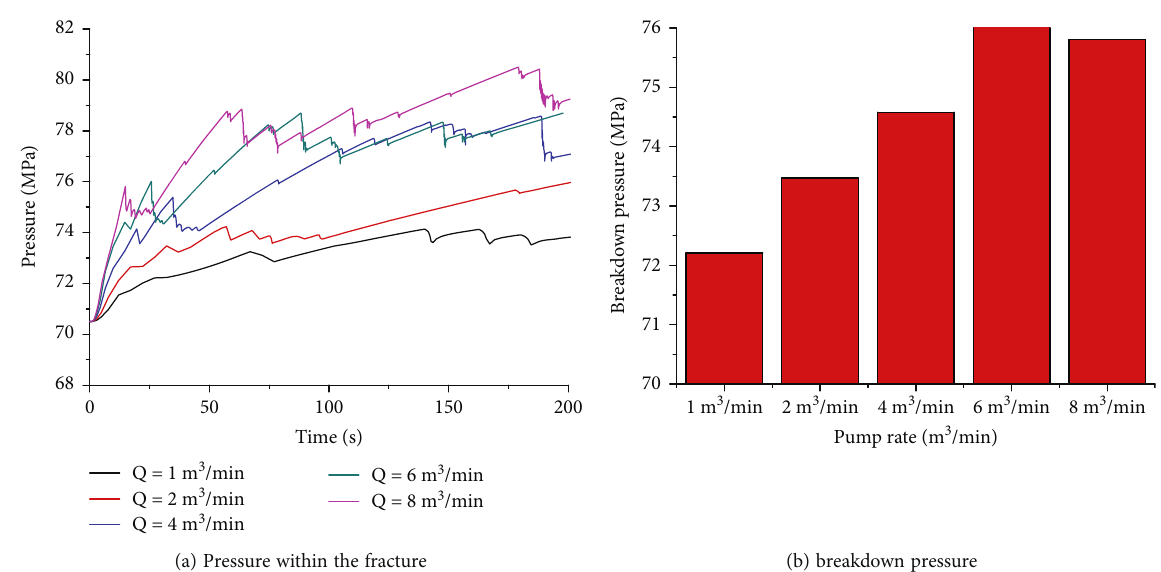
Figure 29: Pressure within the fracture and fracture pressure at the NF approaching angle of 45 ° and at the injection rate of 1-8m 3